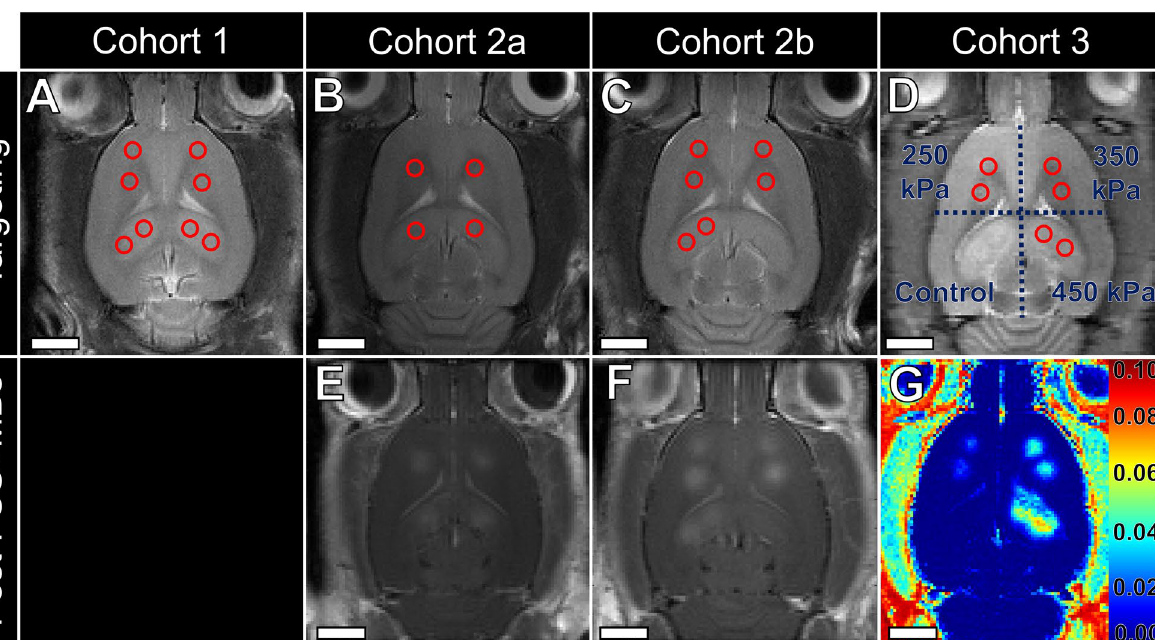
Figure 2. Targeting and post-sonication imaging for each animal cohort. In each animal cohort, magnetic resonance (MR) images were acquired using a T2-weighted sequence for target selection (top row). ( A ) Animals in cohort #1 each received fixed peak negative pressure (PNP; 250 kPa) sonications at 8 targets (red open circles) with no post-focused ultrasound and microbubble (FUS + MB) exposure imaging. Animals in cohort #2 each received sonications at either 4 ( B ; cohort #2a) or 6 targets ( C ; cohort #2b). PNP was calibrated at each target by acoustic feedback control. ( E , F ) Contrast-enhanced T1-weighted imaging was performed approximately 10 min following sonication. ( D ) Animals in cohort #3 each received fixed PNP sonications at 6 targets with (G) post-FUS + MB exposure dynamic contrast-enhanced-MRI to assess blood–brain barrier permeability (colorbar indicates K trans of gadobutrol in units of min −1 ). ( D ) Two targets of equal PNP were placed in each quadrant, while the remaining quadrant served as a non-sonicated control region. The quadrant acting as the non-sonicated control region for animals in cohorts 2b and 3 was shifted to account for regional variance. Scale bars = 4